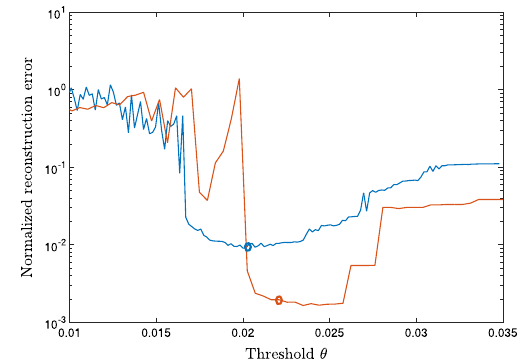
Fig. 2 Variation of the StOMP reconstruction error as a function of the threshold parameter h for two different datasets (see Sect. 4.1, Fig. 4). For each dataset, h was varied for the same compression ratio and